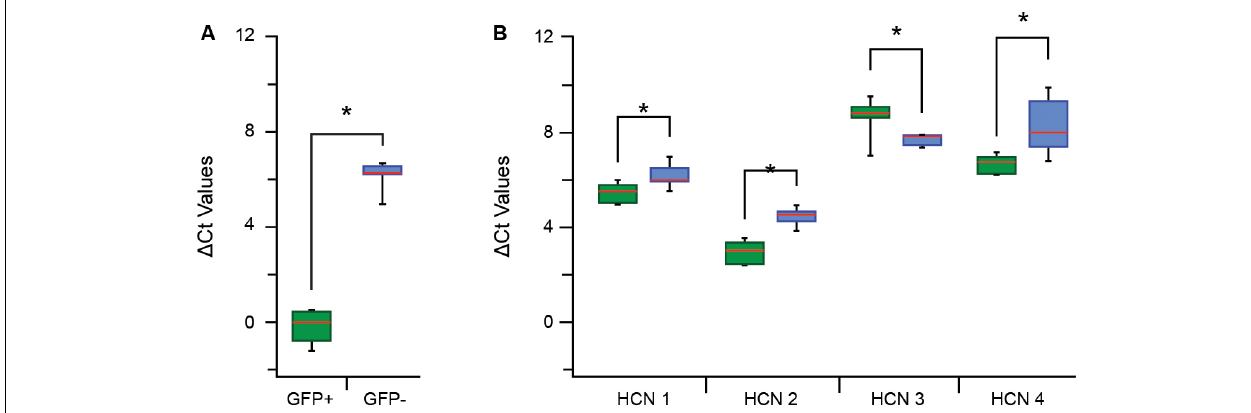
FIGURE 5 | Quantitative polymerase chain reaction (qPCR) ∆ Ct analysis for hyperpolarization-activated cyclic nucleotide-gated channel (HCN channel) subunits in proprioceptive DRG cells. (A) Box and whisker plot show group data comparing ∆ Ct for GFP expression in GFP+ (green) and GFP − (blue) samples (normalized to β actin expression). The low GFP ∆ Ct in GFP+, but not GFP − , confirm high expression in this sample and the reliability of this sampling approach. (B) Box whisker plots plot shows group data comparing ∆ Ct values for HCN1–4 in GFP+ (green) and GFP − (blue) samples. The expression of all HCN subunits was significantly different between GFP+ and GFP − groups (where * p < 0.05). HCN 2 had the greatest overall expression in both samples whilst HCN 3 and 4 were both expressed at much lower levels. Expression levels were highest for HCN 2, then HCN 1 and HCN 4 in the GFP+ sample and these values all exceeded corresponding values in the GFP − samples. In contrast, HCN 3 expression was lower in the GFP+ sample vs. GFP − cells.